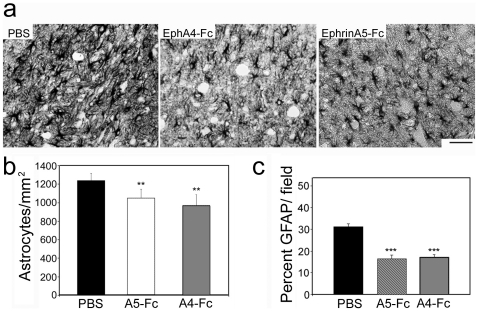
Unclustered ephrin-A5-Fc and EphA4-Fc partially reduce astrocytic gliosis.(A–C) Immunohistochemical analysis of GFAP expression 4 days after spinal cord hemisection and following 3 days administration of Fc fusion protein indicated that, (A) compared to PBS treatment (n = 6), ephrin-A5-Fc (n = 3) and EphA4-Fc (n = 3) treatment decreased astrocytic gliosis. There were significant decreases in the number of astrocytes (B) and GFAP density at the lesion site was reduced following ephrin-A5-Fc or EphA4-Fc treatment (C). Results in B and C show mean±SEM, **p<0.01, ***p<0.001, using one-way ANOVA with Tukey's multiple comparison test. Scale bar in A, 100 µm.